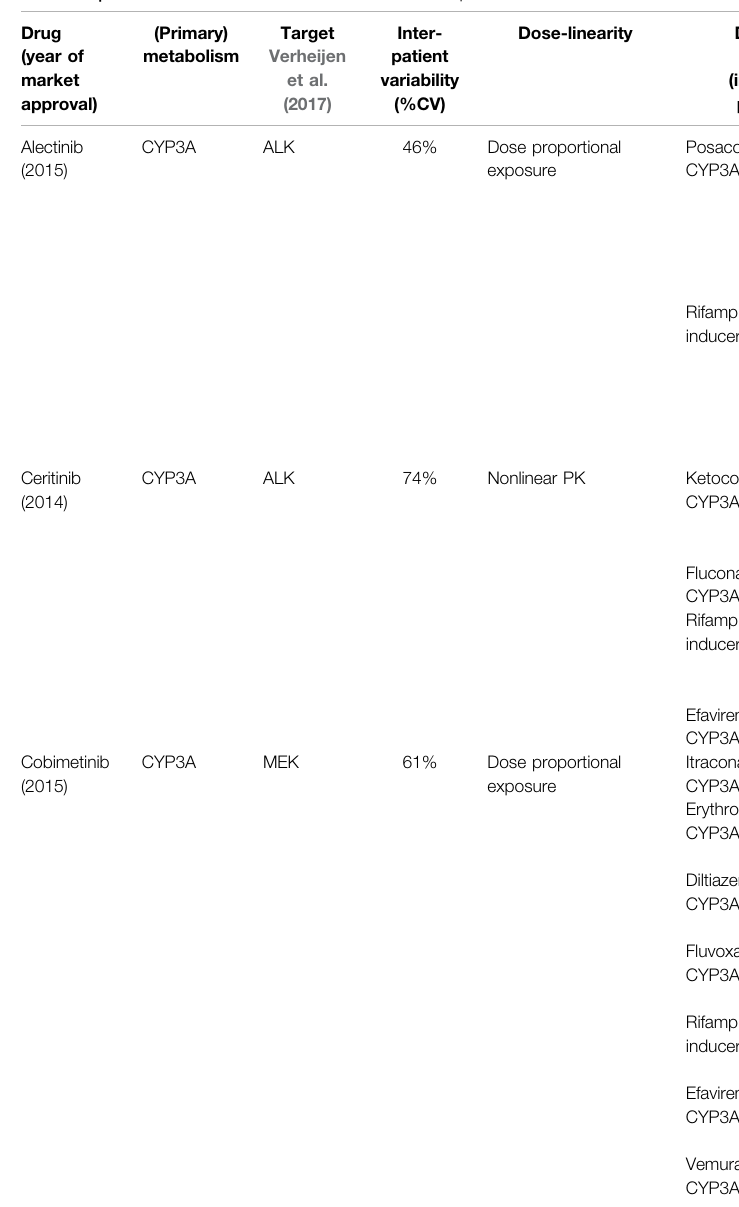
TABLE 2 | Detailed overview of the results of DDI studies performed with the reviewed oral oncolytic